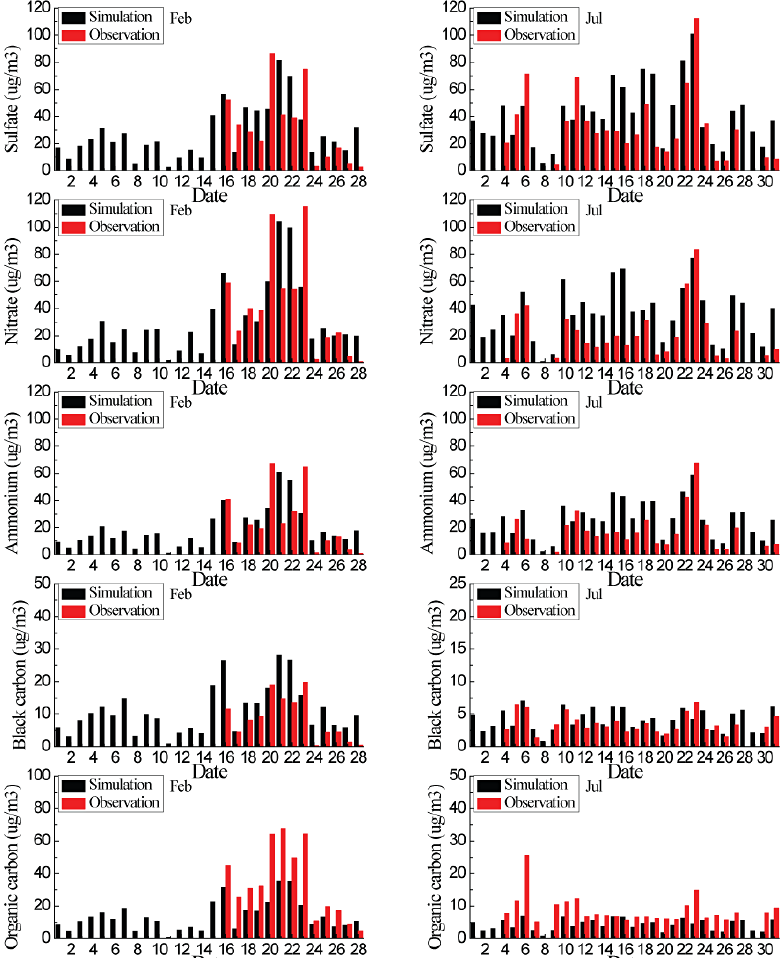
Figure 11. Observed (red bars) and modeled (black bars) daily-average mass concentrations (µgm − 3 ) of sulfate, nitrate, ammonium, black carbon, and organic carbon in February and July 2011 in